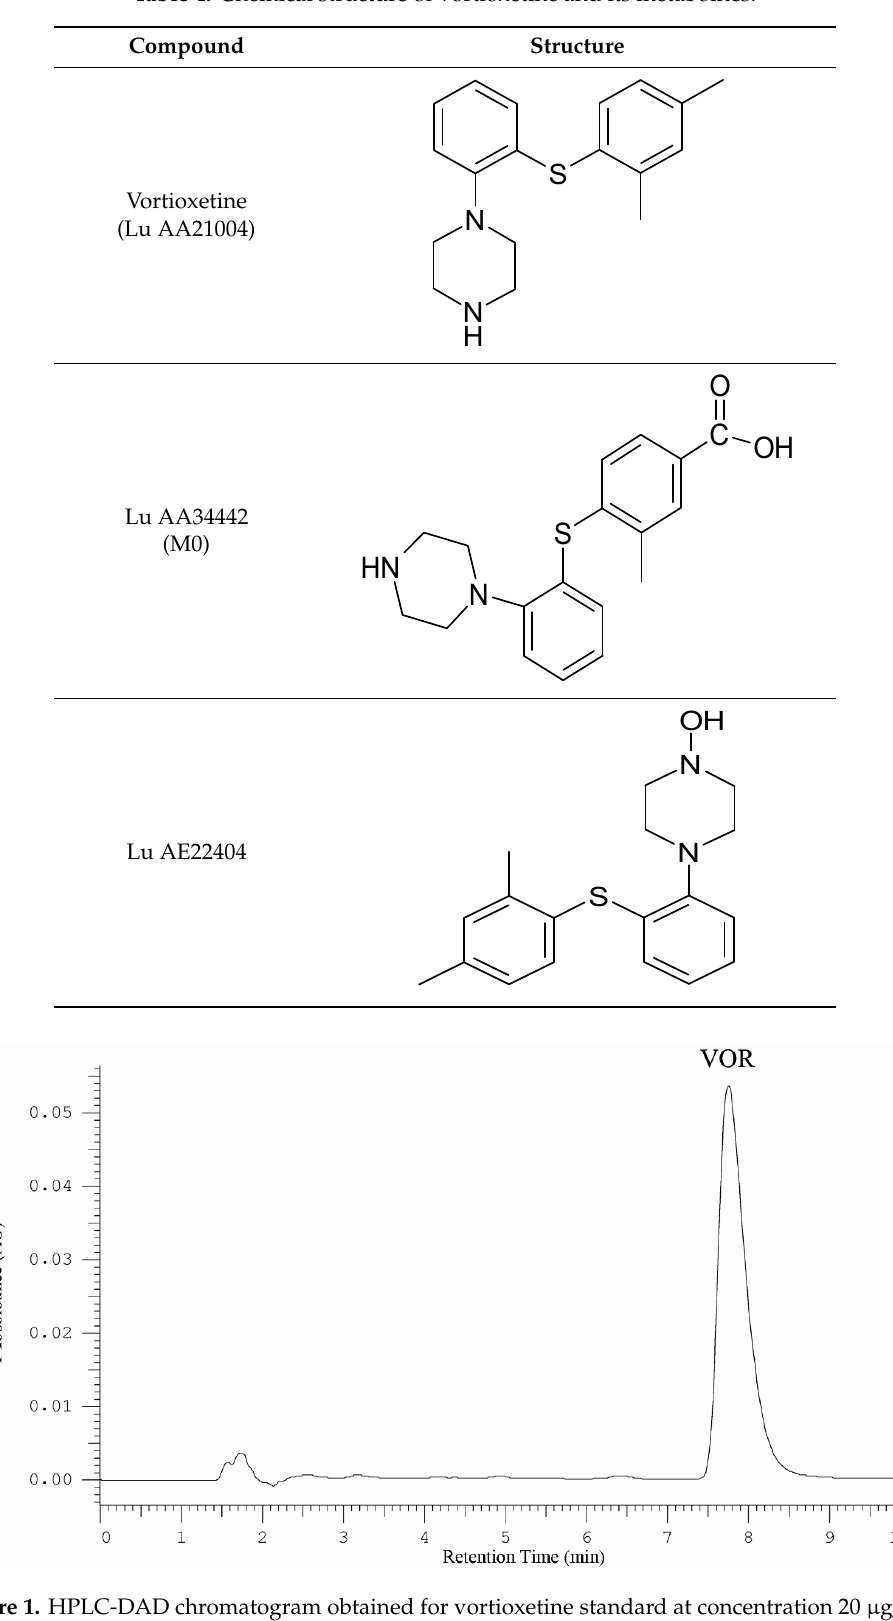
Figure 1. HPLC-DAD chromatogram obtained for vortioxetine standard at concentration 20 µ g /